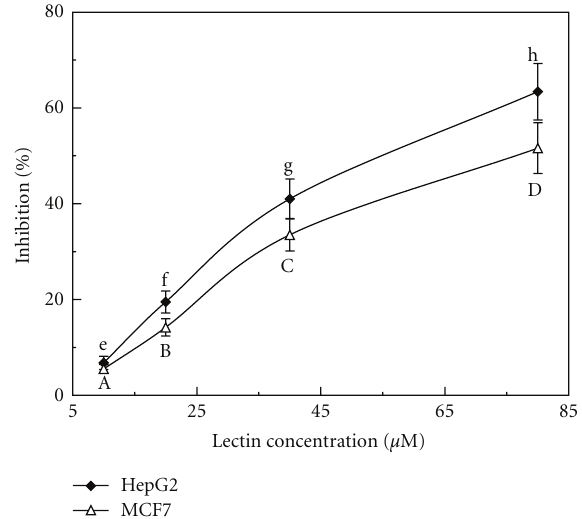
Figure 5: Mitogenic response of murine splenocytes to the lectin isolated from H. erinaceum as reflected by uptake of [methyl- 3 H] thymidine uptake in vitro. Results represent means ± SD ( n = 3). Maximal stimulation of thymidine uptake was brought about by a lectin concentration of 20 μ M. There was an approximately 36-fold increase over the control value without lectin. Di ff erent alphabets next to the data points indicate statistically significant di ff erence ( P < . 05) when the data are analyzed by analysis of variance followed by Duncan’s multiple range